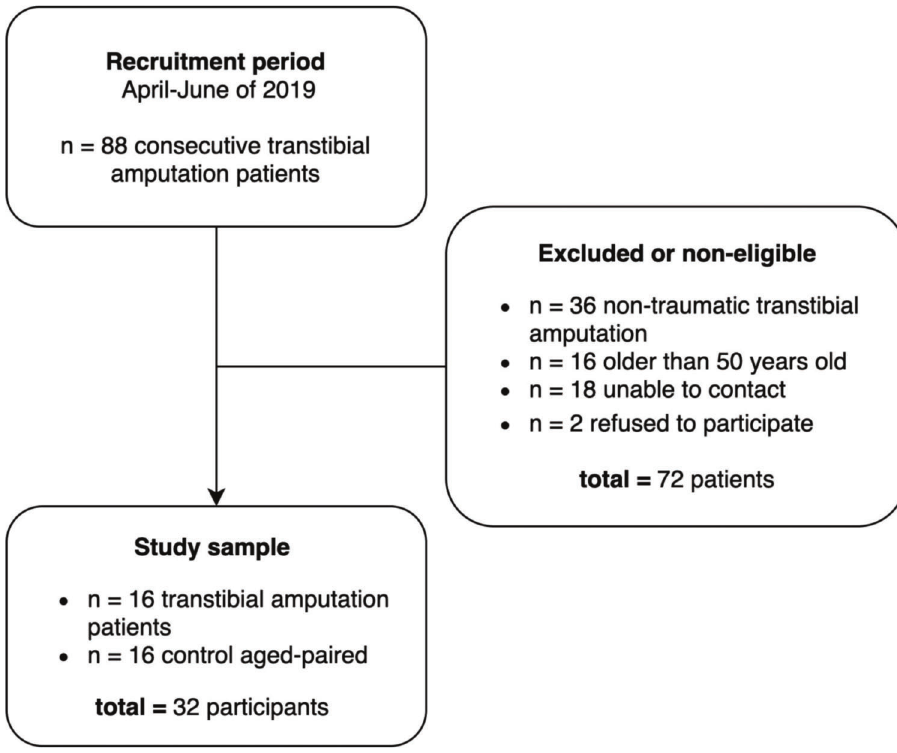
Figure 2 - A flow diagram of the recruitment, total eligible participants, and the final sample in the Table 2 - Bodyweight distribution, proprioception, and muscular strength in amputees and control subjects. Variable